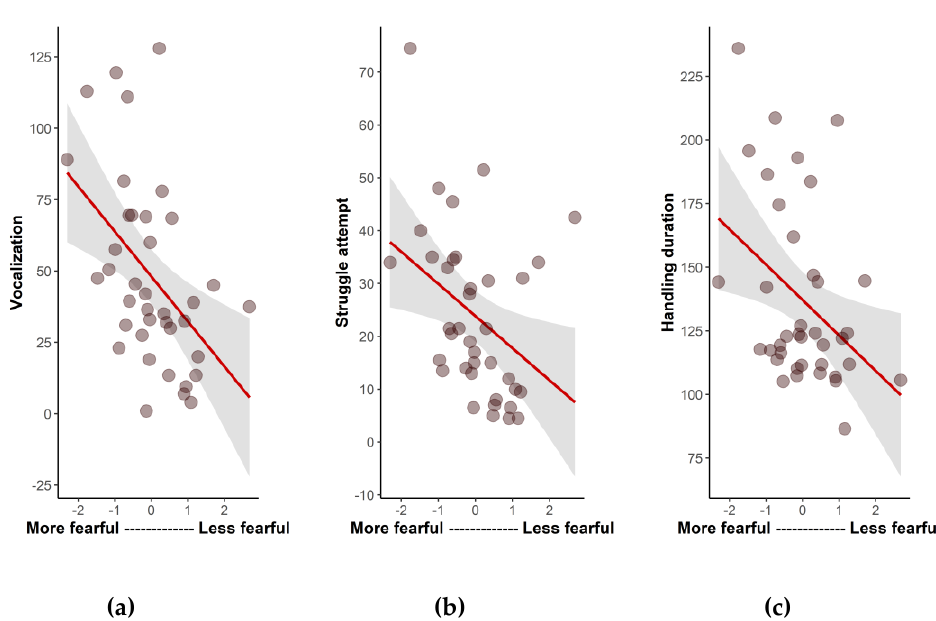
Figure 2. Significant Spearman’s correlations between the fearfulness temperament dimension and the variables obtained during the manual restraint test) for the 38 parrots: ( a ) vocalization; ( b ) struggle attempts; ( c ) handling duration (s).